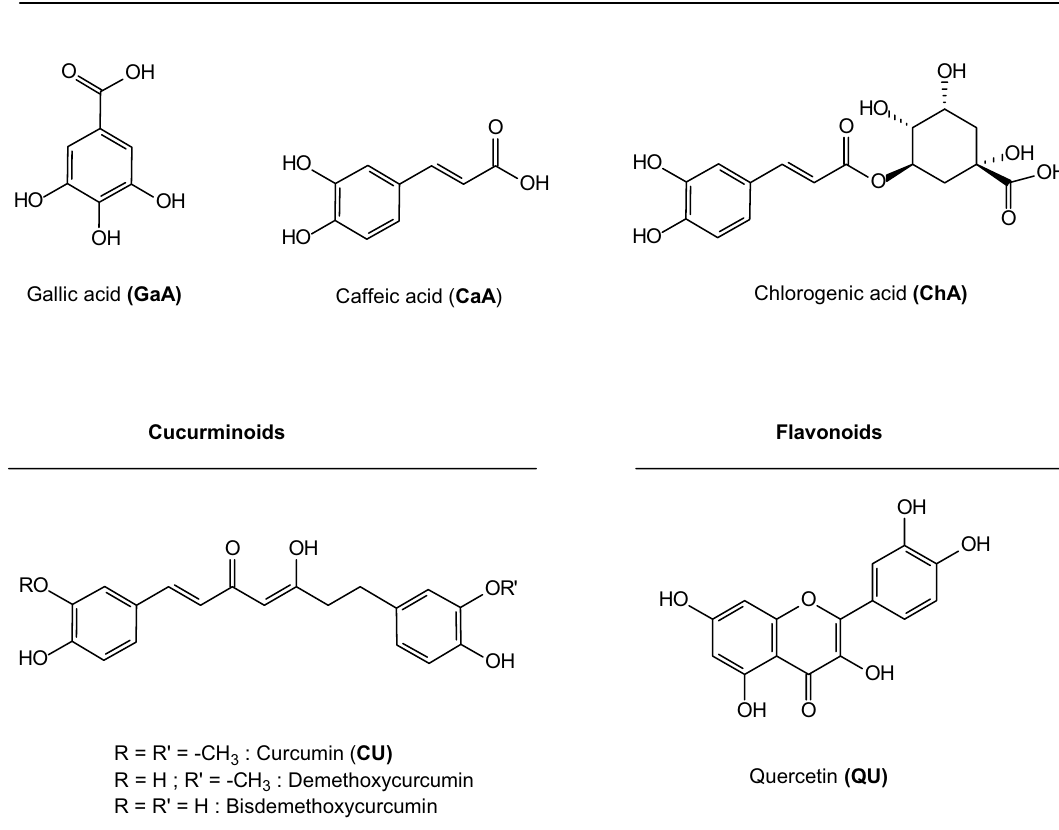
Figure 1. Phenolics with related chemical structural